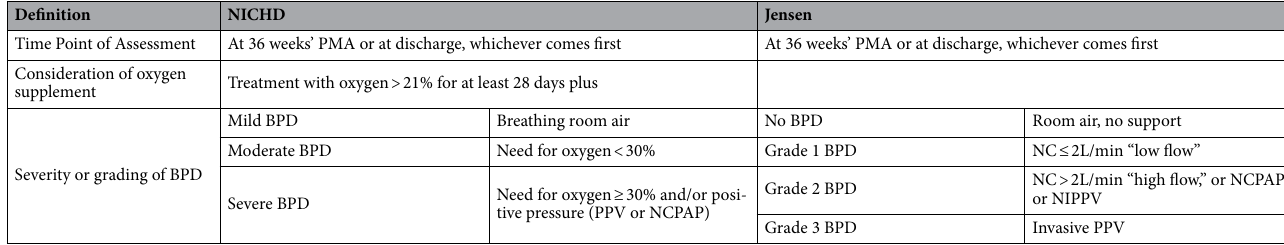
Table 1. Definitions of bronchopulmonary dysplasia. BPD Bronchopulmonary dysplasia; GA Gestational age; NC Nasal cannula; NCPAP Nasal continuous positive airway pressure; NIPPV Nasal intermittent